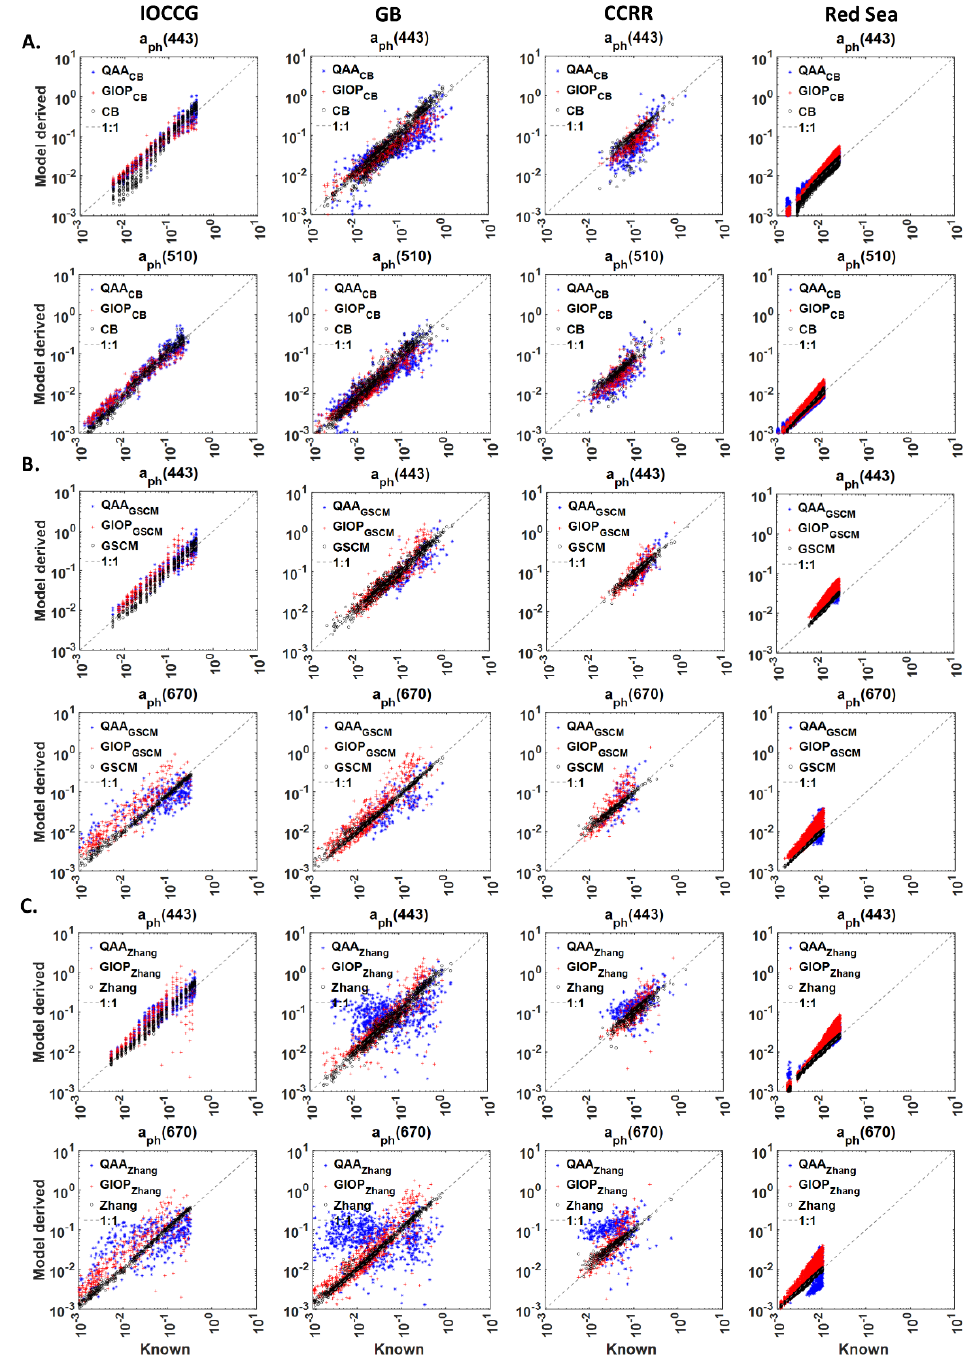
Figure 7. Comparison of model-derived and known (measured or synthetic) values of the phytoplankton absorption coefficient, a ph from ( A ). GIOP CB , QAA CB and CB models at 443 and 510 nm, ( B ). GIOP GSCM , QAA GSCM and GSCM models at 443 and 670 nm, ( C ). QAA Zhang , GIOP Zhang and Zhang’s models at 443 and 670 nm. The hybrid models QAA CB , QAA GSCM , QAA Zhang , GIOP CB , GIOP GSCM and GIOP Zhang models use R rs (λ) , spectral remote sensing reflectance to derive absorption subcomponents. Blue dots and red plus indicate the hybrid models that use GIOP and QAA in the first step. The absorption decomposition algorithms, CB, GSCM and Zhang’s (Black circles) models, use a nw (λ) , spectral non-water absorption coefficient to derive the absorption subcomponents, λ is the wavelength. The inputs for the models, i.e., R rs (λ) and a nw (λ) are taken from the four datasets, IOCCG, GB, CCRR and the Red Sea. The 1:1 relationship is shown in a grey dotted line.